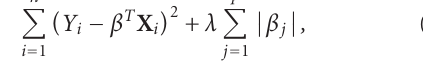
problem of classification into two groups is reexpressed